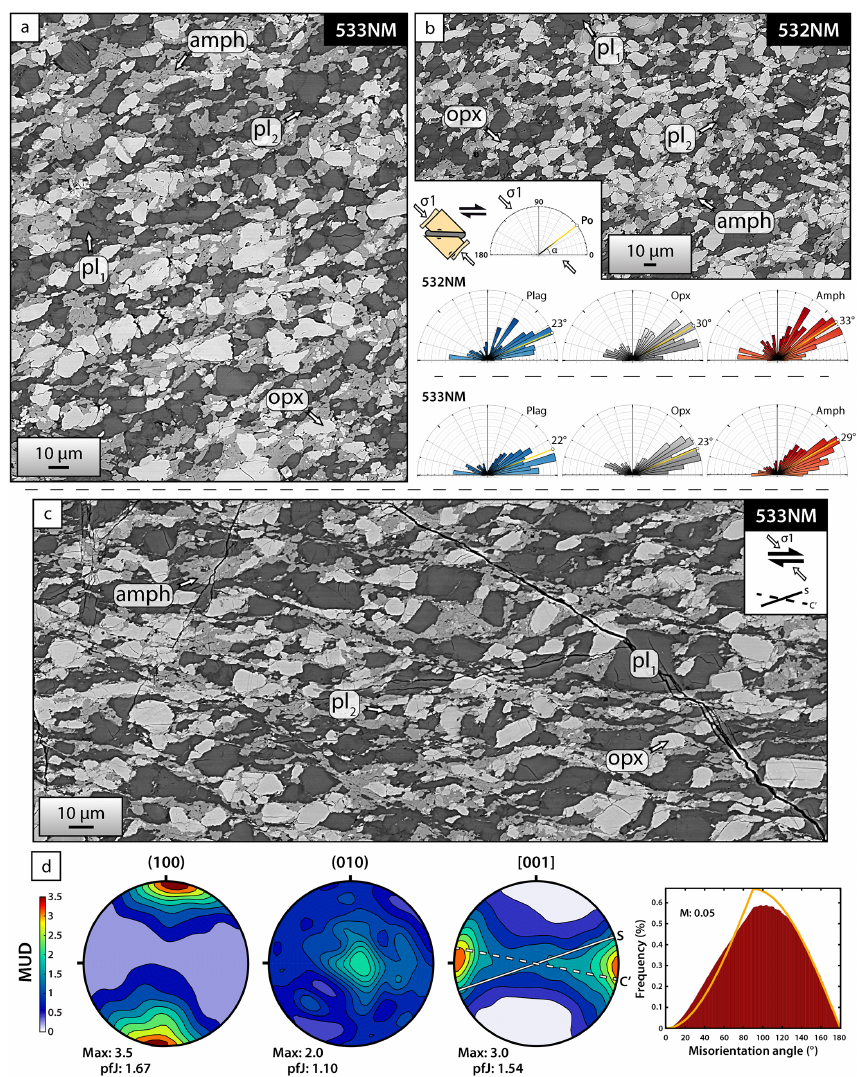
Figure 12. SPO and amph LPOs in the Fe-rich opx + plag assemblages. (a–b) Rose diagrams of the SPO of plag 1 , opx 1 , and amph ( a : 533NM – 850 ◦ C, b : 532NM – 900 ◦ C). (c) Strongly deformed part of the Fe-rich opx + plag assemblage deformed at 850 ◦ C. (d) Amph LPOs are shown for the (100) plane, (010) plane, and [001] axis with respect to the shear direction, considering one point per grain. Number of data points: 365; step size: 100nm; average grain size of amphibole: 4.1µm. pfJ: pole figure texture index, MUD: multiple of uniform distribution, opx: orthopyroxene, pl: plagioclase, amph: